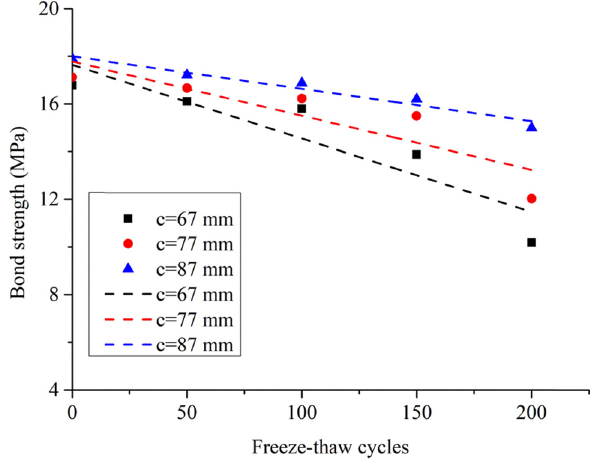
Figure 8: In fl uence of concrete cover depth on bond